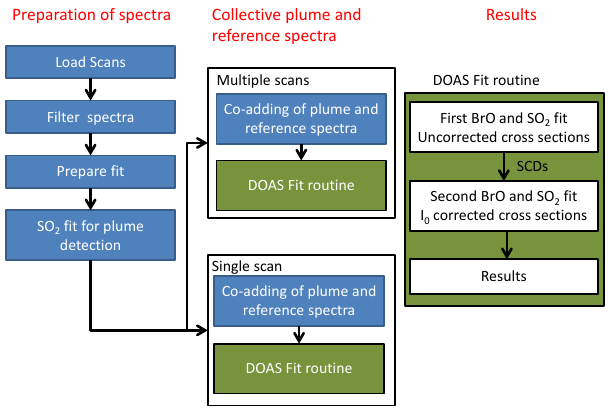
Figure 3. Flow chart of the data evaluation to automatically retrieve BrO / SO 2